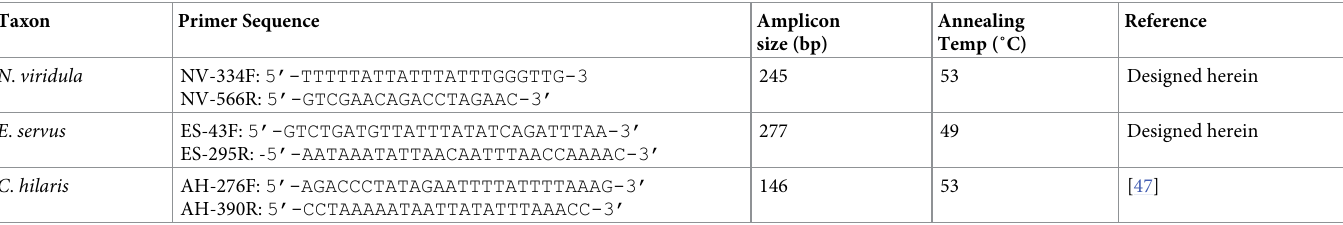
Table 3. Primer names and sequences for taxa tested for consumption by